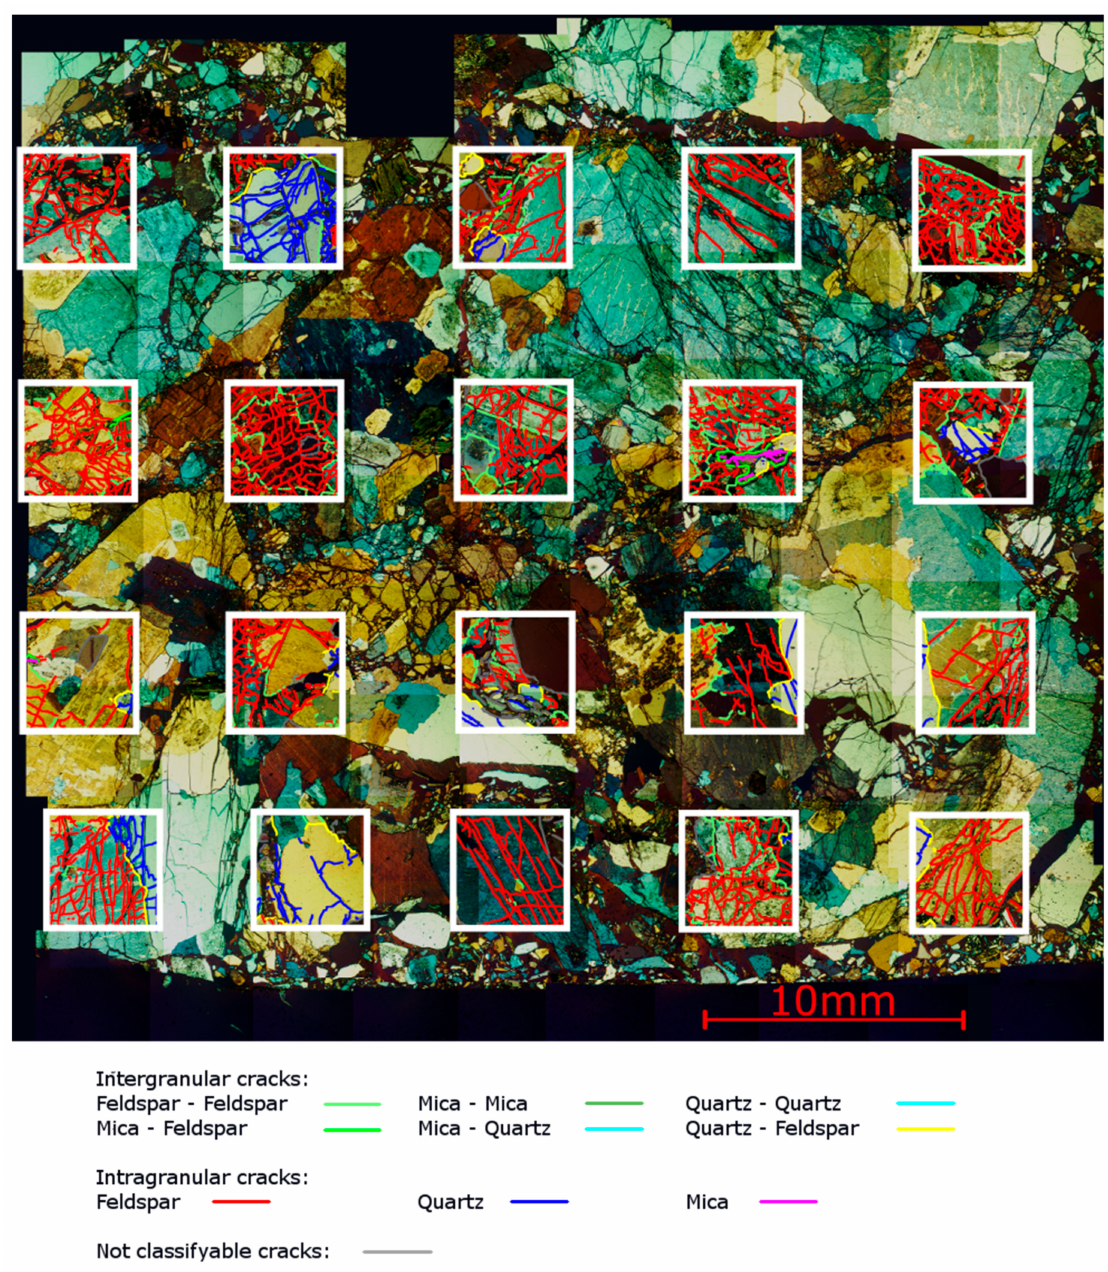
Figure 6. Thin section of the grouted particle bed under polarized light with analysis raster: Cracks are marked by colors according to the involved mineral phases. Cracks smaller than 1 mm are not marked in this view for clarity